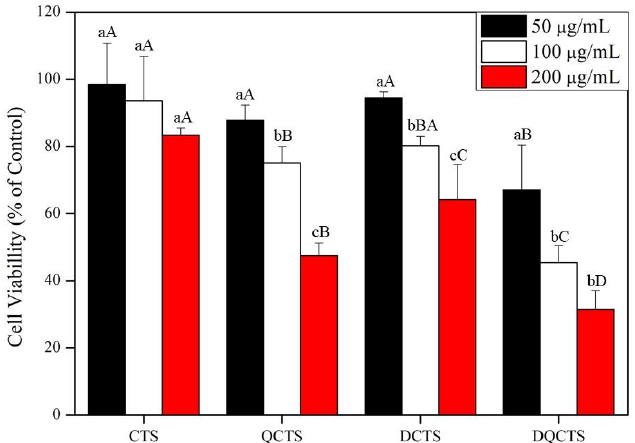
Figure 5. Cell viability of HaCaT cells treated with chitosan compounds at 50, 100, and 200 μg/mL. The results were presented as three independent experiments’ mean ( n = 3) ± standard deviation (SD). a–c means values in each concentration with a different letter are significantly different by Duncan’s multiple range test at p < 0.05. A–D means values in each chitosan compound with a different letter are significantly different by Duncan’s multiple range test at p < 0.05. CTS: chitosan, QCTS: quaternized chitosan, DCTS: fully deacetylated chitosan, DQCTS: fully deacetylated quaternized chitosan.